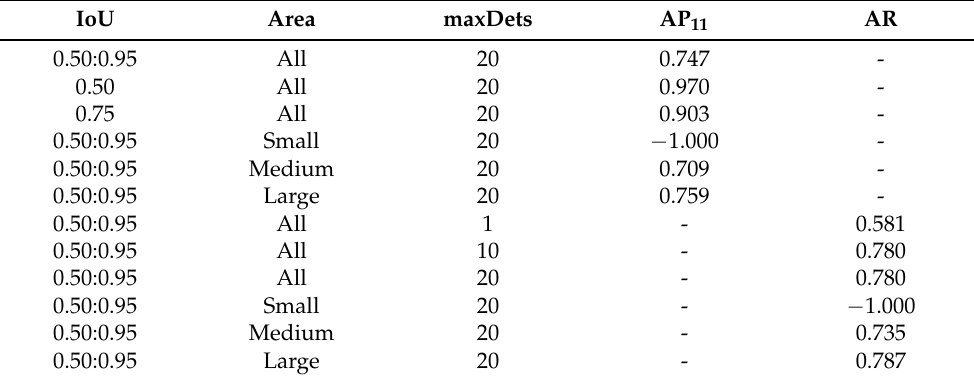
Table 8. Results of the YOLO-GD with quantization using COCO